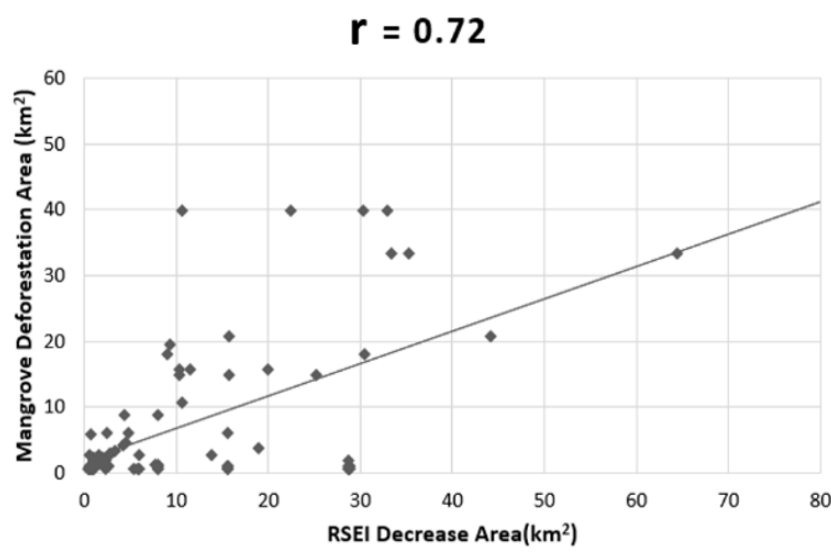
Figure 16. Correlation between the areas of RSEI decline and mangrove deforestation.